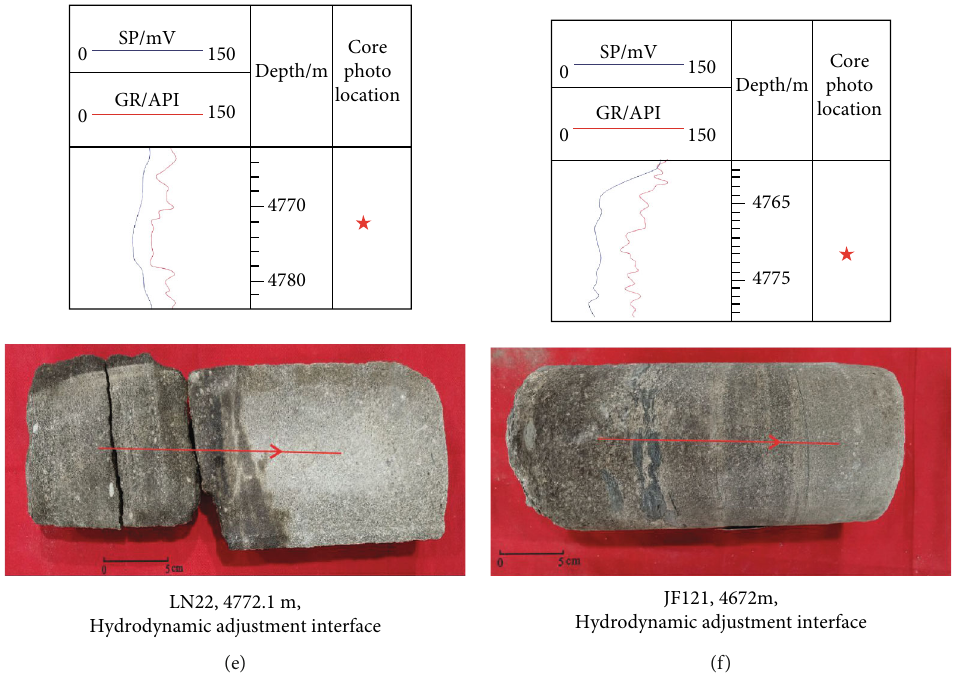
Figure 3: Core photos of typical hydrodynamic adjustment interface from TIII1 sand group in Sangtamu Oil fi eld.